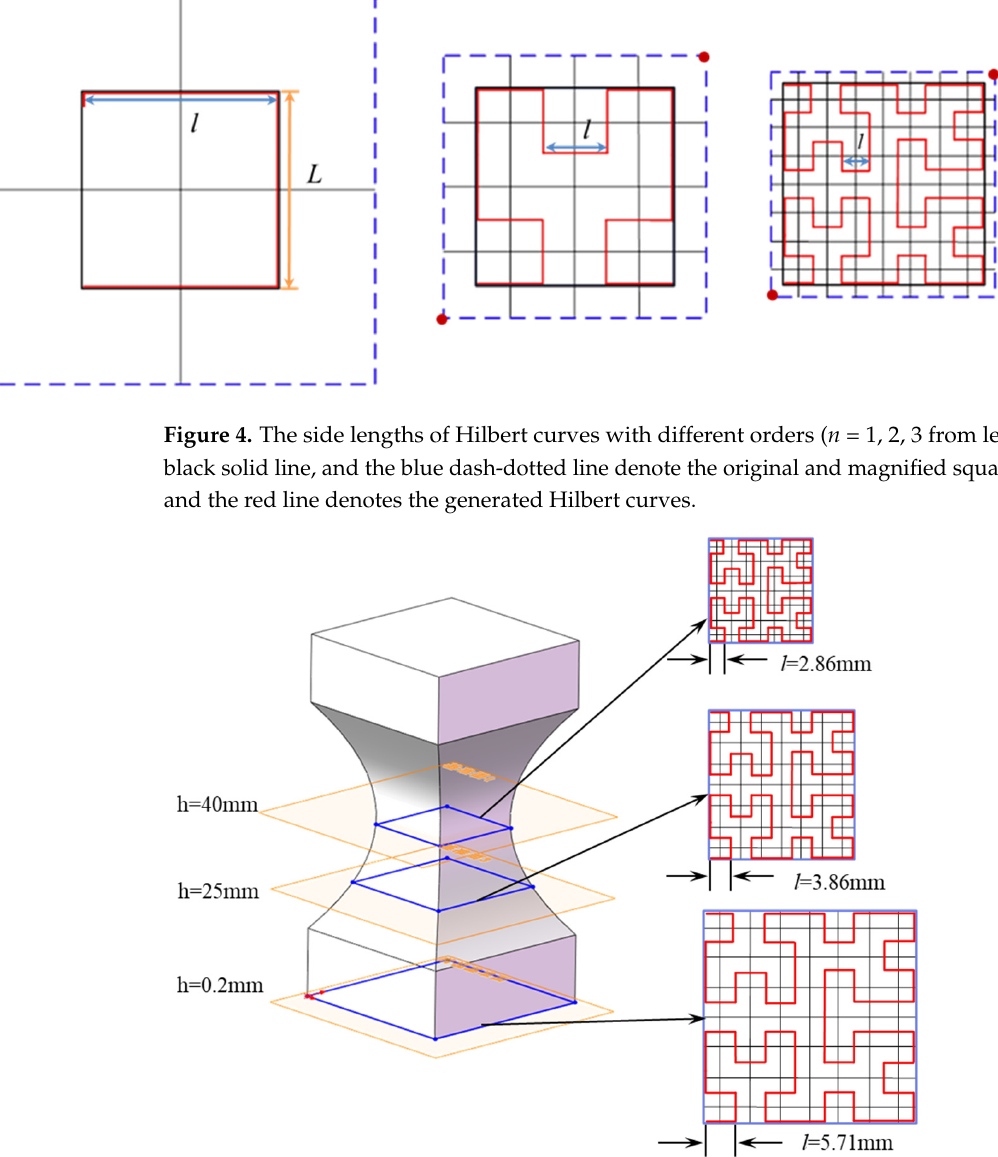
Figure 5. The adaptive density filling structure with the Hilbert curve with the same order.